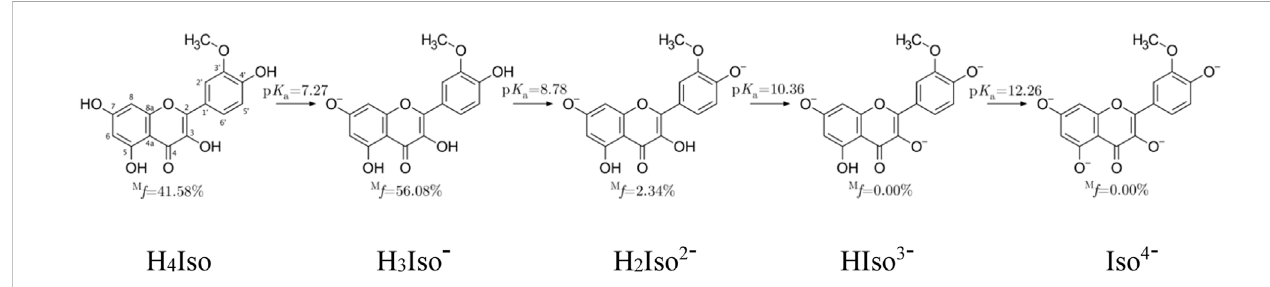
FIGURE 1 Dissociation constants and molar fractions for isorhamnetin species at pH = 7.4.